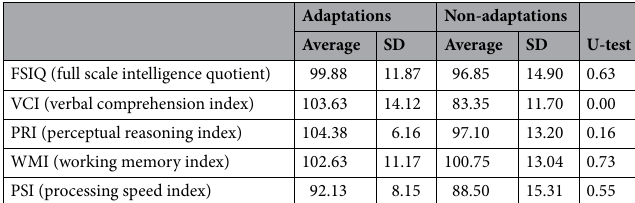
Table 6. Examination for intelligence